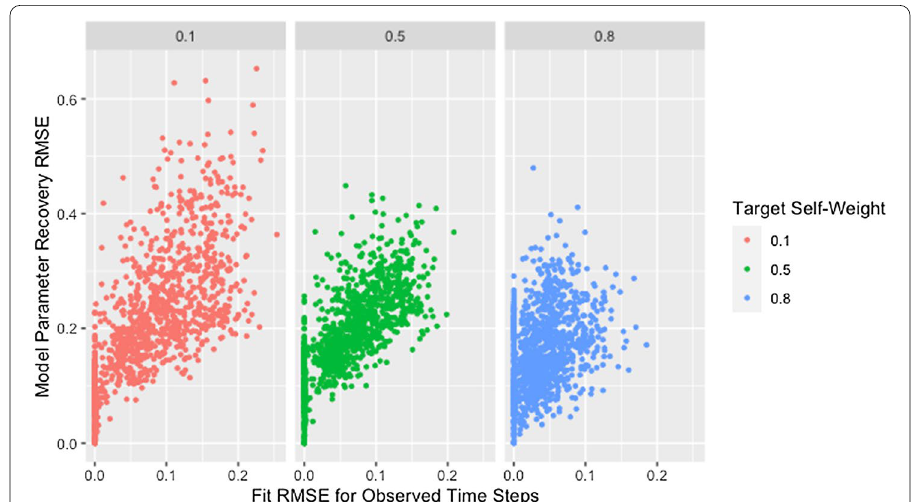
Fig. 5 RMSE for model parameter recovery by fit RMSE and self-weight. RMSE for known and predicted weights by RMSE for observed and predicted opinions on observed time steps and target self-weight